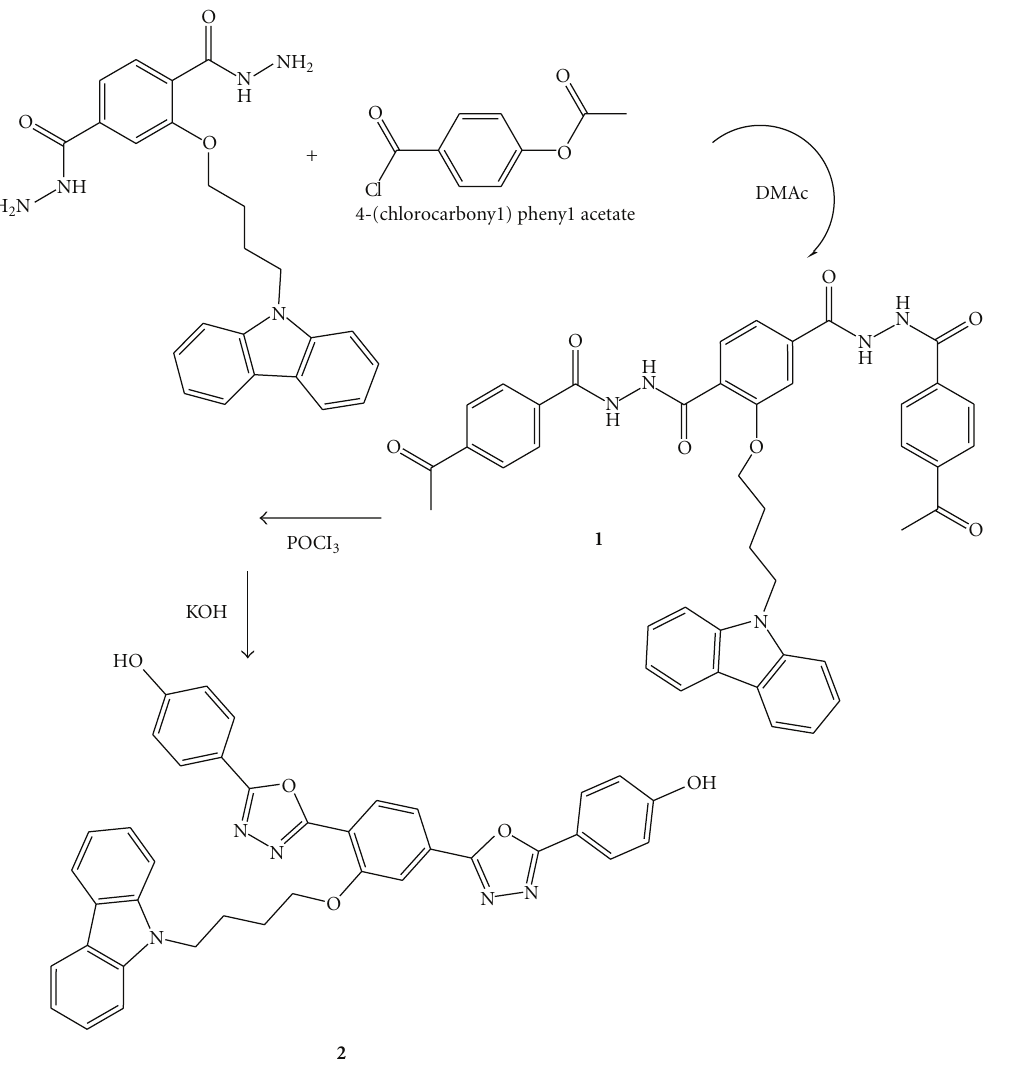
Scheme 2: Synthesis of the monomer.